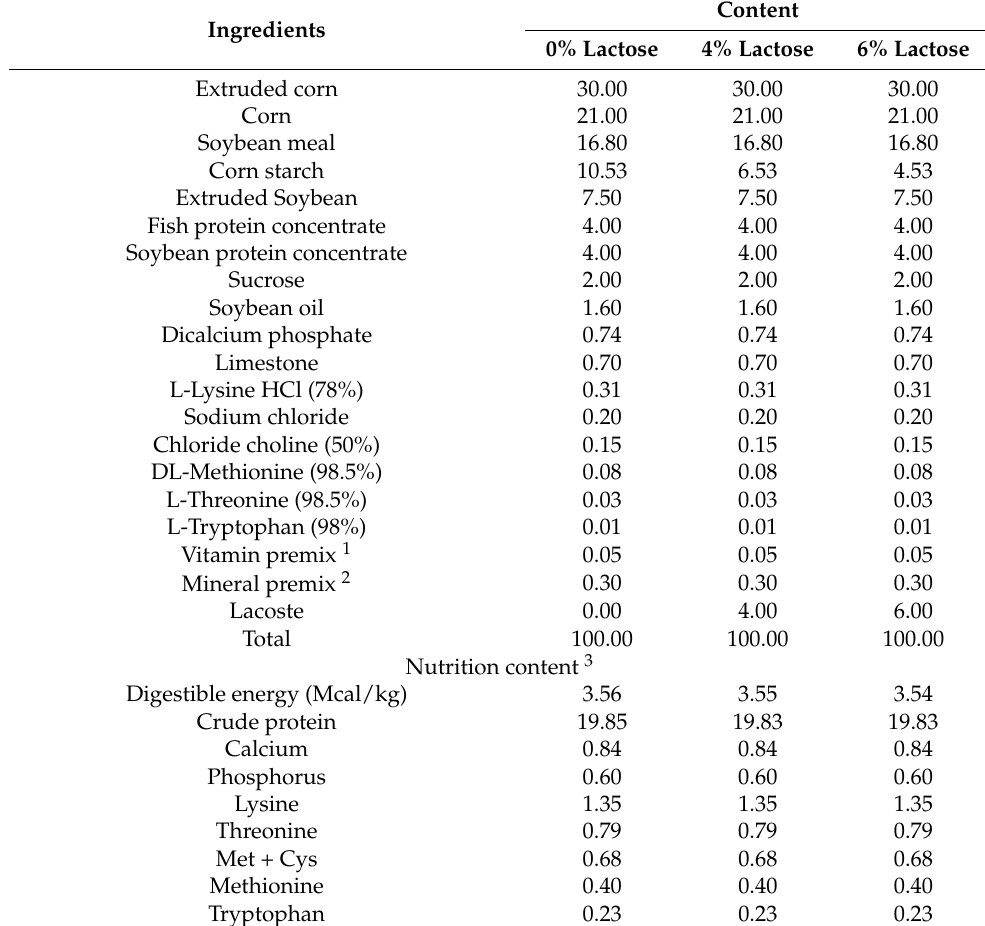
Table 1. The composition and nutrient contents of experimental diets